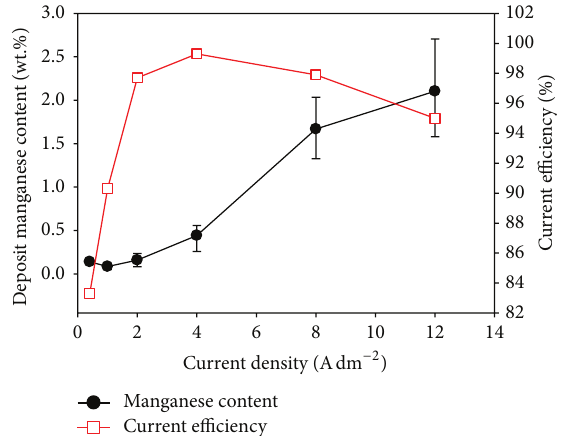
Figure 2: The effect of current density on the current efficiency of the deposition and Mn content of the coating.